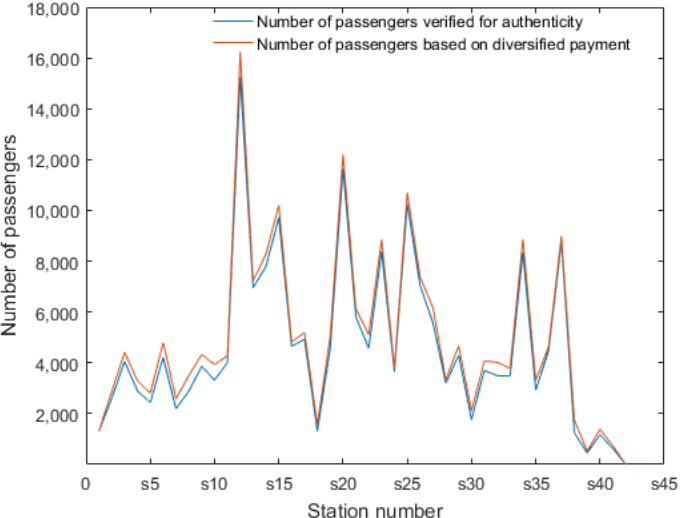
Figure 7. Statistical results of the authenticity-verified monthly passenger-flow data according to station number (downward bus lines).